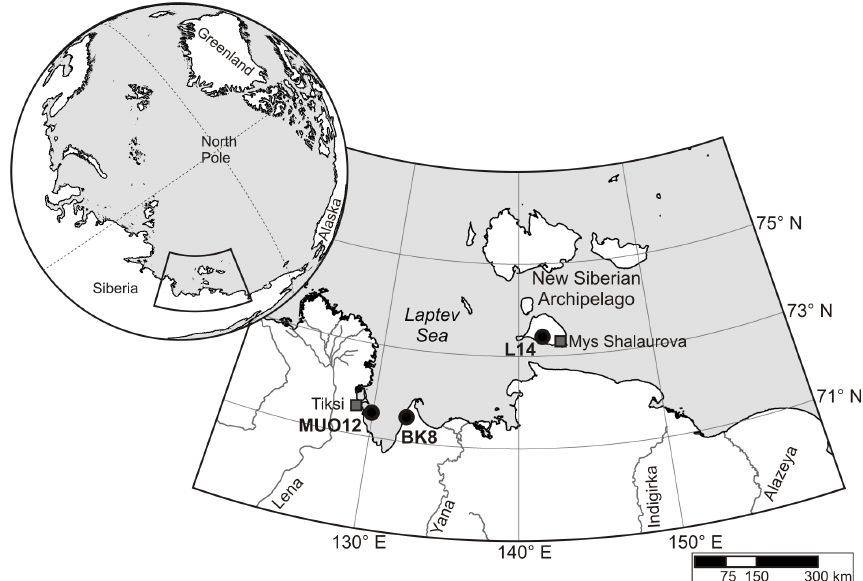
Figure 1. Overview of the Laptev Sea region with the study locations at Muostakh Island (sample code MUO12), the Buor Khaya Peninsula (BK8) and Bol’shoy Lyakhovsky Island